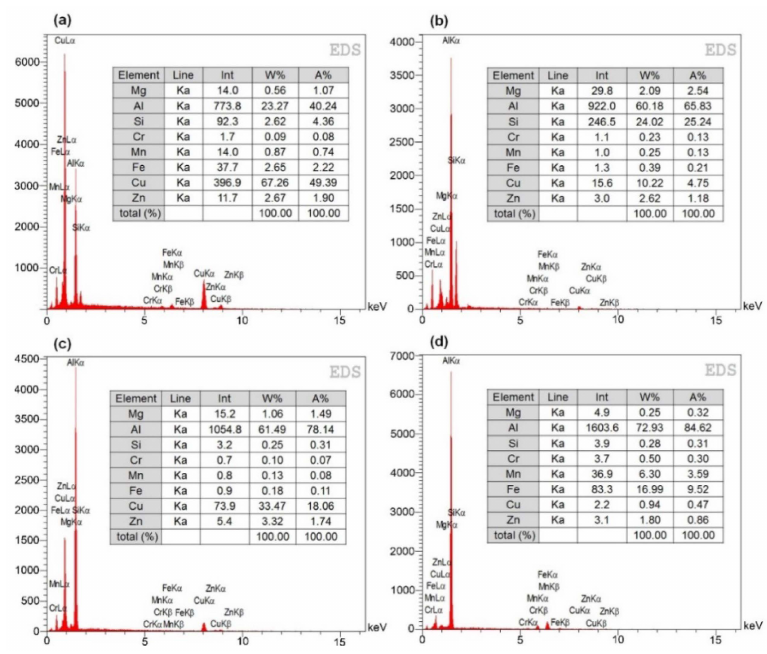
Figure 7. SEM/EDS analysis of various points in Figure 6: ( a ) A; ( b ) B; ( c ) C; ( d )